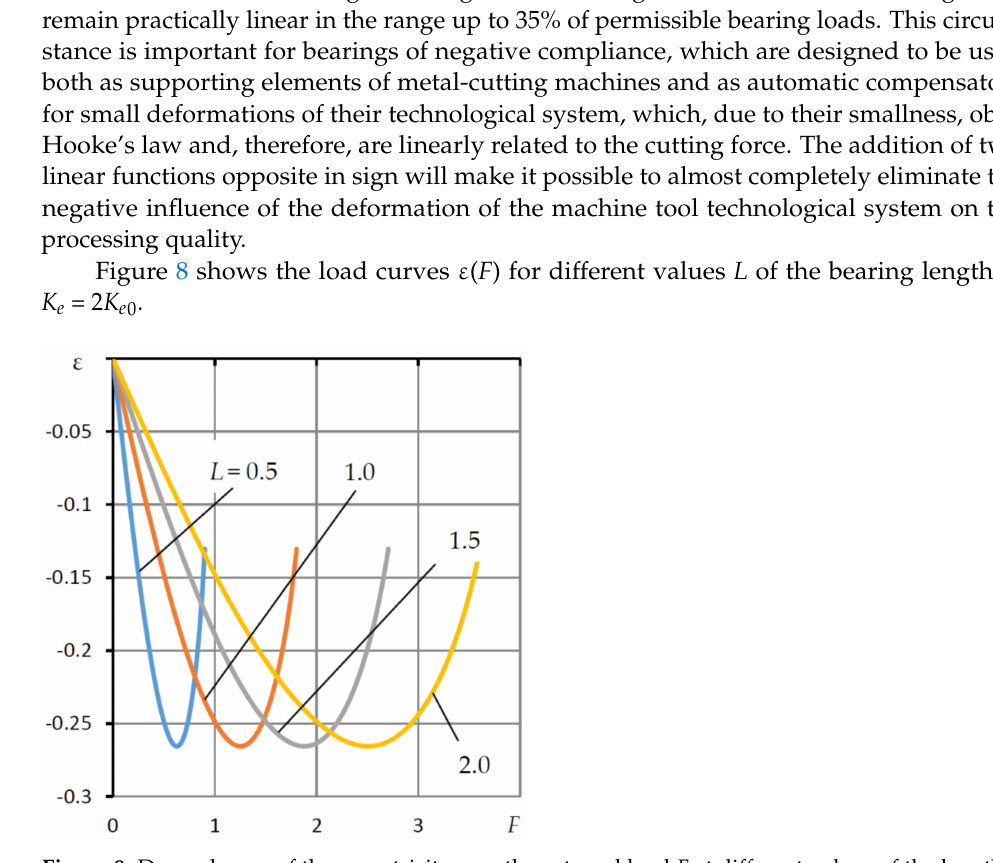
Figure 8. Dependences of the eccentricity ε on the external load F at different values of the length L and the coefficient of elasticity K e = 2 K e 0